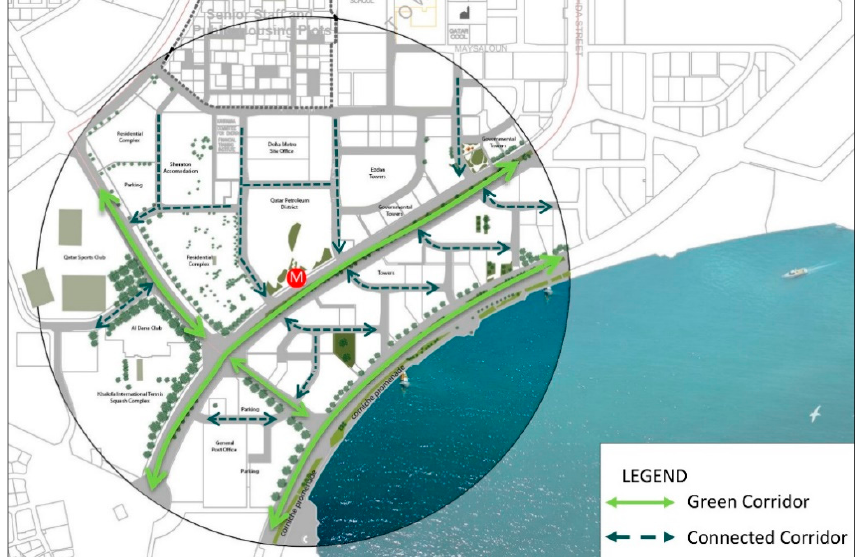
Figure 24. Illustration of the concept of green corridors; the red circle with the “M” shows the location of the West Bay metro station (Source: the Authors).